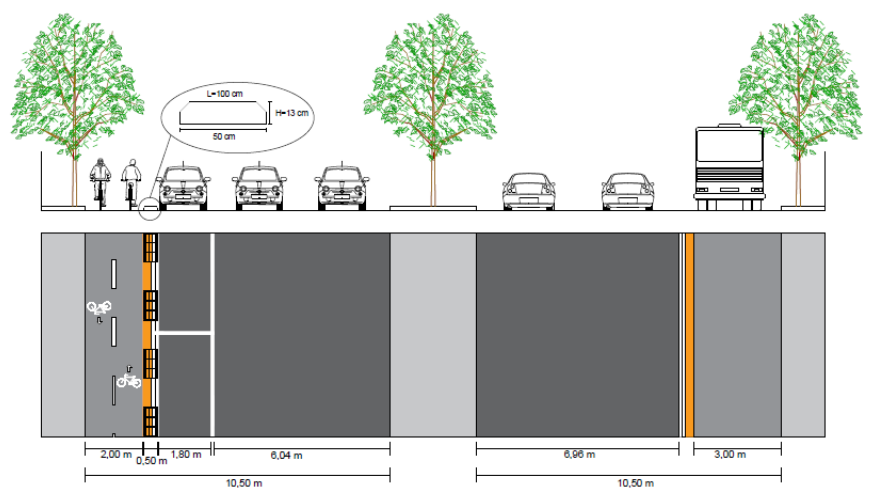
Figure 6. Part of the plan of the new cycle paths.